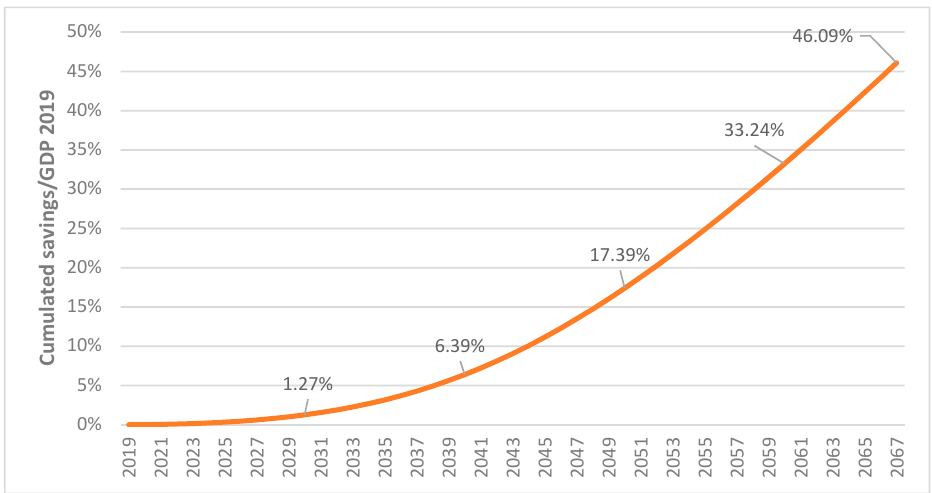
Figure 7. Cumulative savings, since 2019, over GDP for 2019, with the application of the sustainability factor. Source: Prepared by the authors.